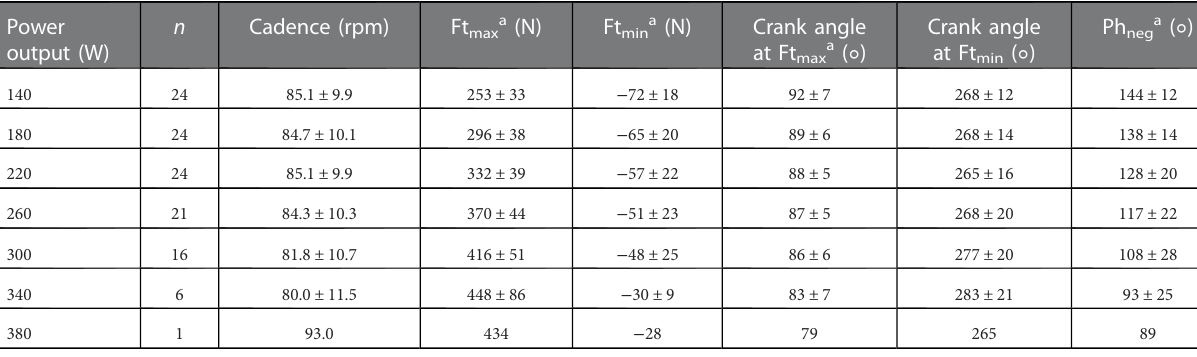
TABLE 2 Cadence and selected tangential pedal force pro fi le characteristics during the submaximal graded test for measurement of power output at a blood lactate concentration of 2.5 mmol L − 1 [W 2.5(L ā ) ]. Data were collapsed for the two groups of cyclists as well as for pretest and posttest. Values are presented as